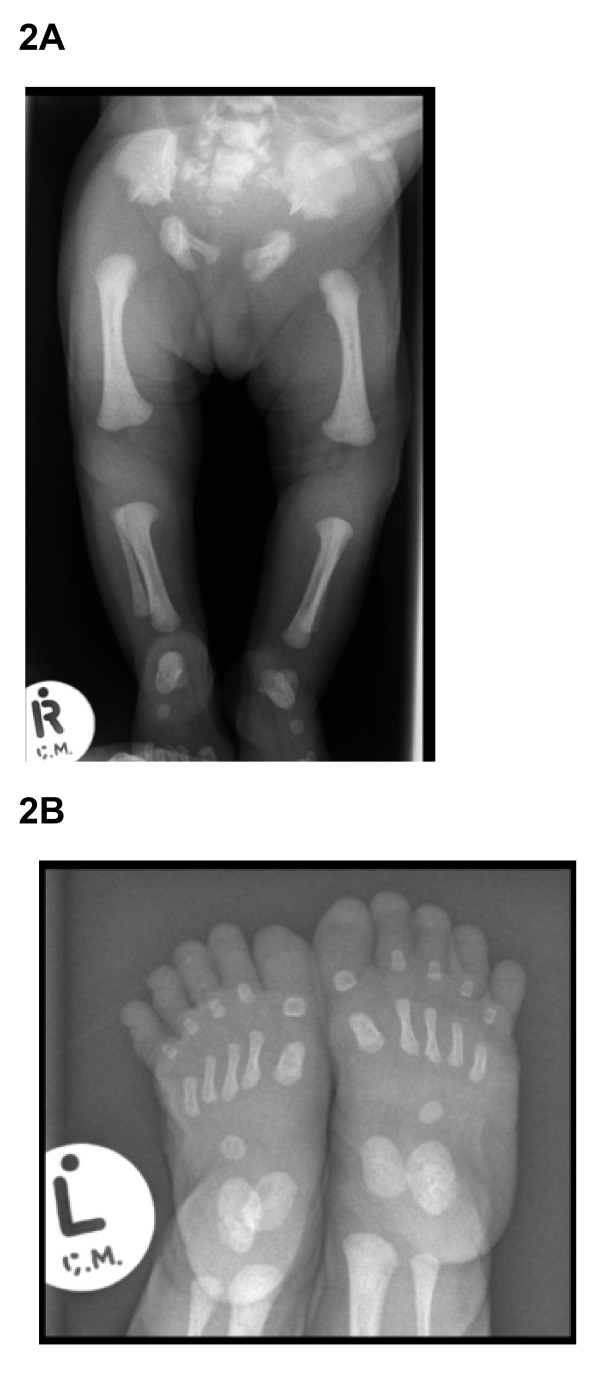
A X-ray of the lower limbs in case 3, note small iliac bones with triradiant acetabulum, short and thick long bones. 1B) X-ray of the feet in case 3 showing hypoplasia of the terminal phalanges.